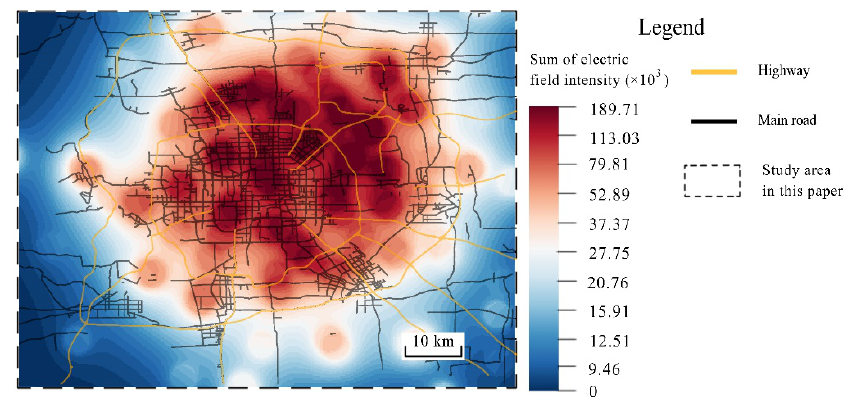
(cid:17)(cid:12) (cid:80)(cid:12) → (cid:12) (cid:12) (cid:16) in the study area. (cid:12) (cid:12) (cid:12) (cid:12) E r ji in the study (cid:12) (cid:12) in the study area. (cid:12) (cid:12) ∑�𝐸𝐸 ( 𝑟𝑟 𝚥𝚥𝚤𝚤 ) �����������⃗� ∑�𝐸𝐸 ( 𝑟𝑟 𝚥𝚥𝚤𝚤 ) �����������⃗�